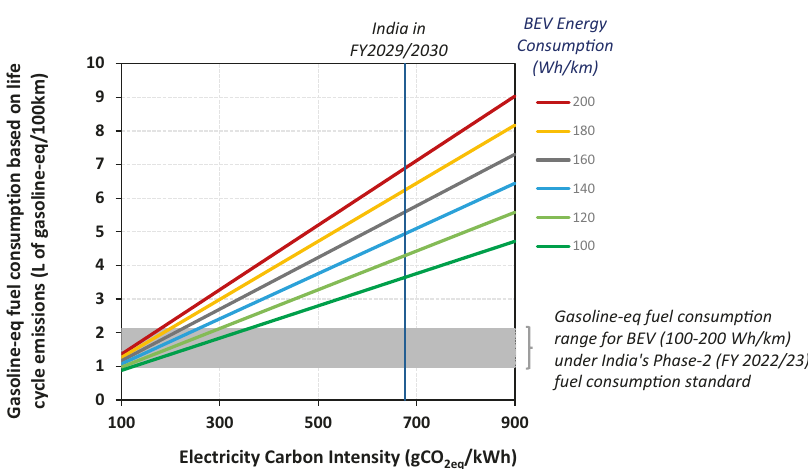
Fig. 8 GHG loophole created by regulation that is based on tailpipe emission only. Relationship between the carbon intensity of India ’ s electricity and the gasoline-equivalent fuel consumption of a battery-electric vehicle (BEV) with different ef fi ciencies based on its total life cycle emission. India ’ s Phase-2 standard assigns a gasoline-equivalent fuel consumption of 1 – 2 L/100 km for BEVs with electricity consumption between 100 and 200 Wh/km regardless of the source of electricity. (Curb weight of BEV = 1237